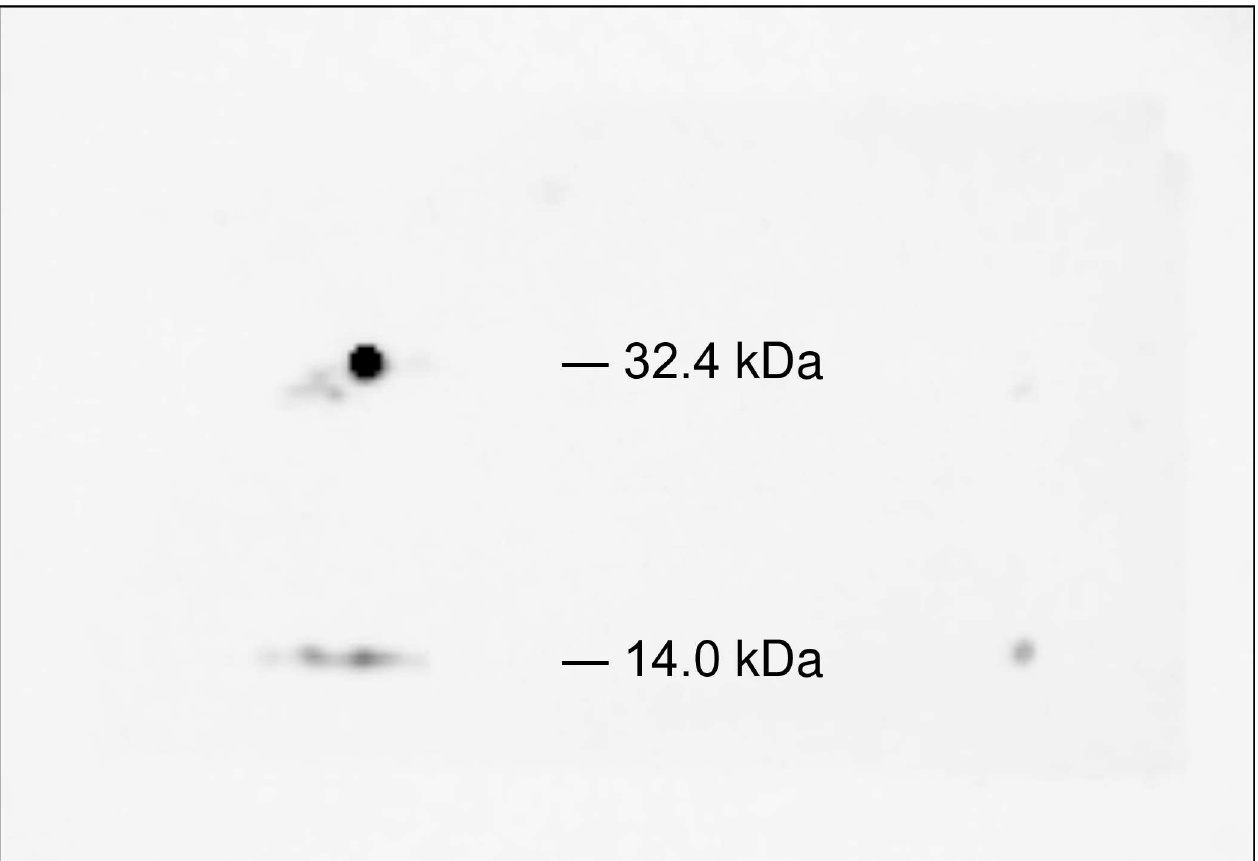
Fig 4. 2D western blot analysis using anti-TTR antibody. The 32.4-kDa spot distinctly reacted with the anti-transthyretin antibody. Weak immunoreaction at 14.0 kDa was also detected and was interpreted as a monomer of TTR. The blotted membrane was stained with gold-colloid stain, and the area of immunoreaction was confirmed to correspondto the 32.4-kDa spot detected by 2D